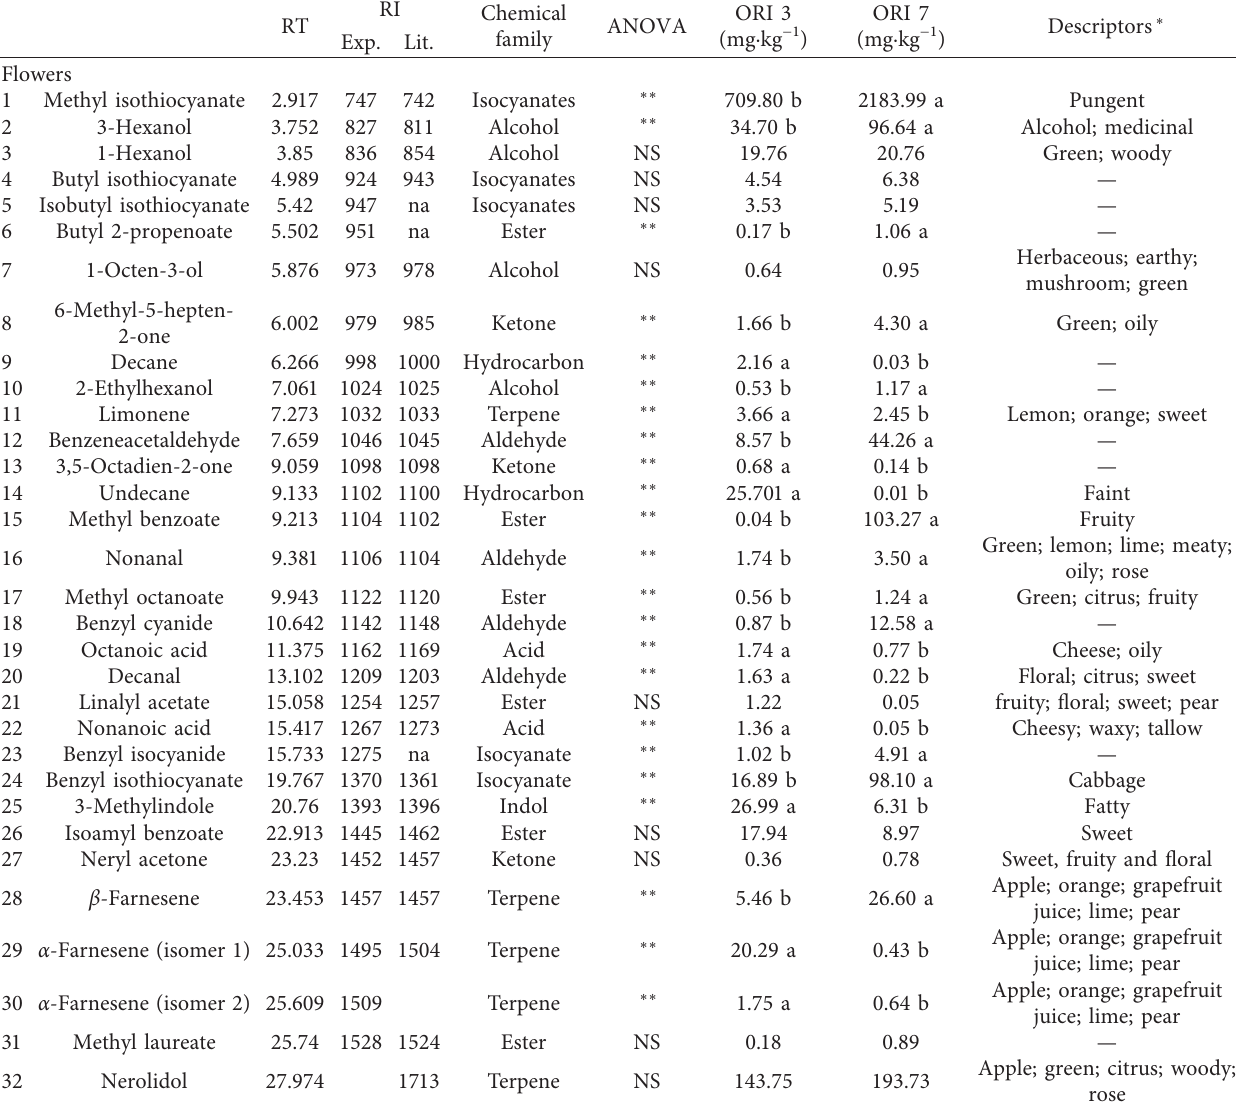
Table 2: Volatile compounds of Capparis spinosa L. in flowers detected using headspace solid phase microextraction (HS-SPME) with GC-